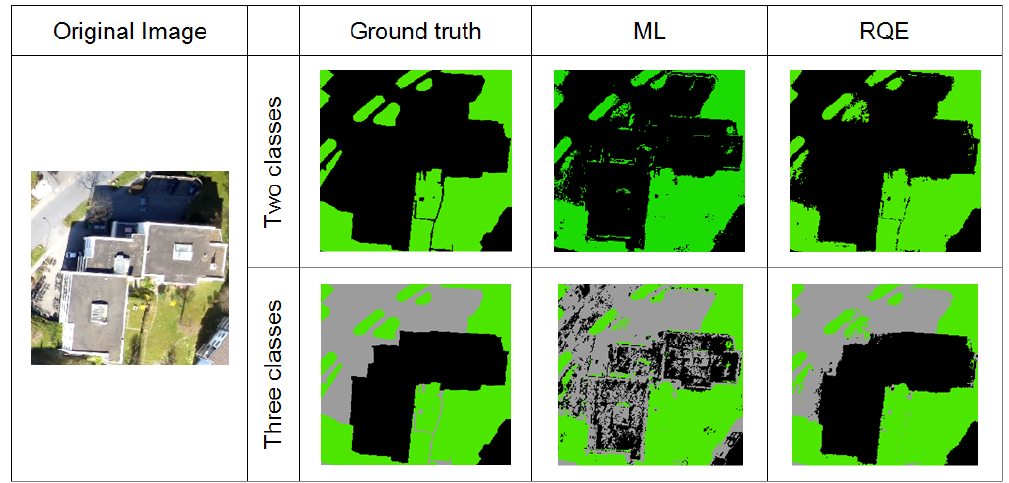
Figure 5. Cutouts of the UAV image: original image, manually labelled ground truth, and classification results using ML and RQE (two and three classes). In the case of two classes, impervious surfaces are black and pervious are green. In the case of three classes, rooftops are black, streets/sidewalks are grey and vegetation is